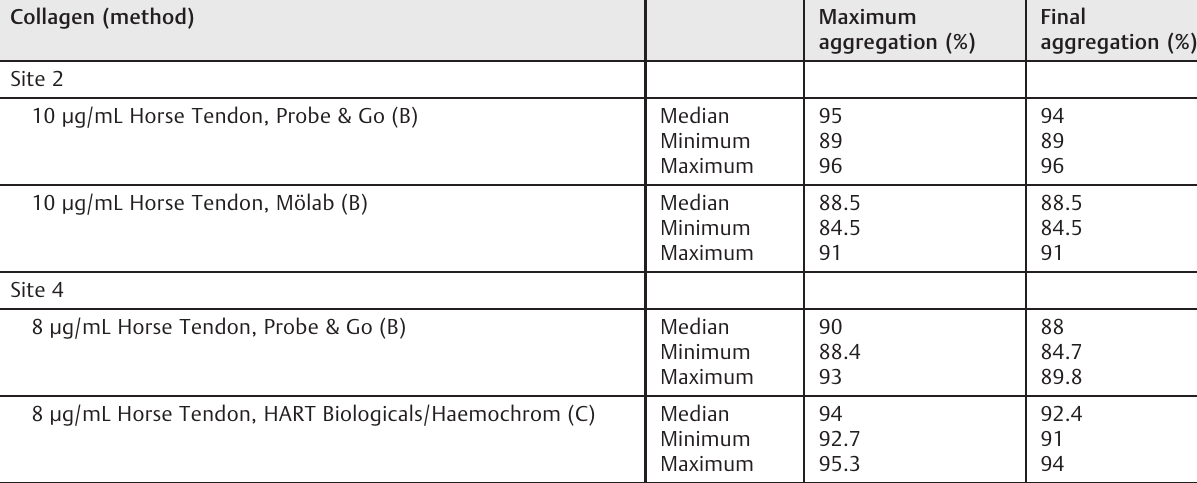
Table 6 In fl uence of collagen manufacturers on aggregometry results Collagen (method) Maximum